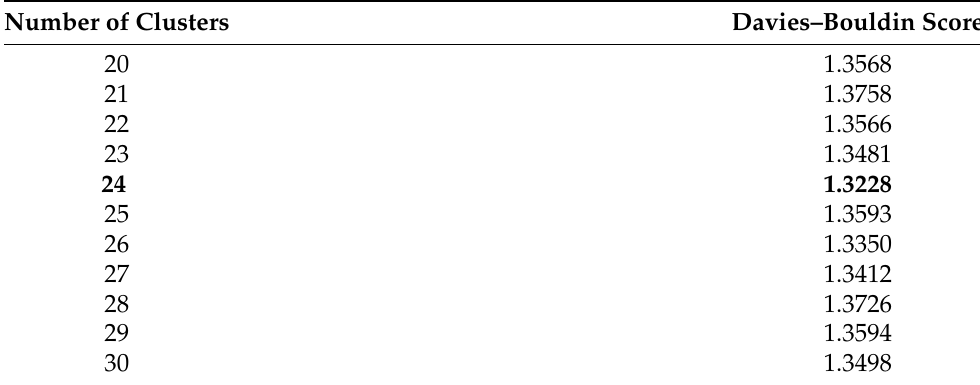
Table 2. Davies–Bouldin scores for differing number of clusters of the codebook vectors of the SOM, based on Ward’s clustering